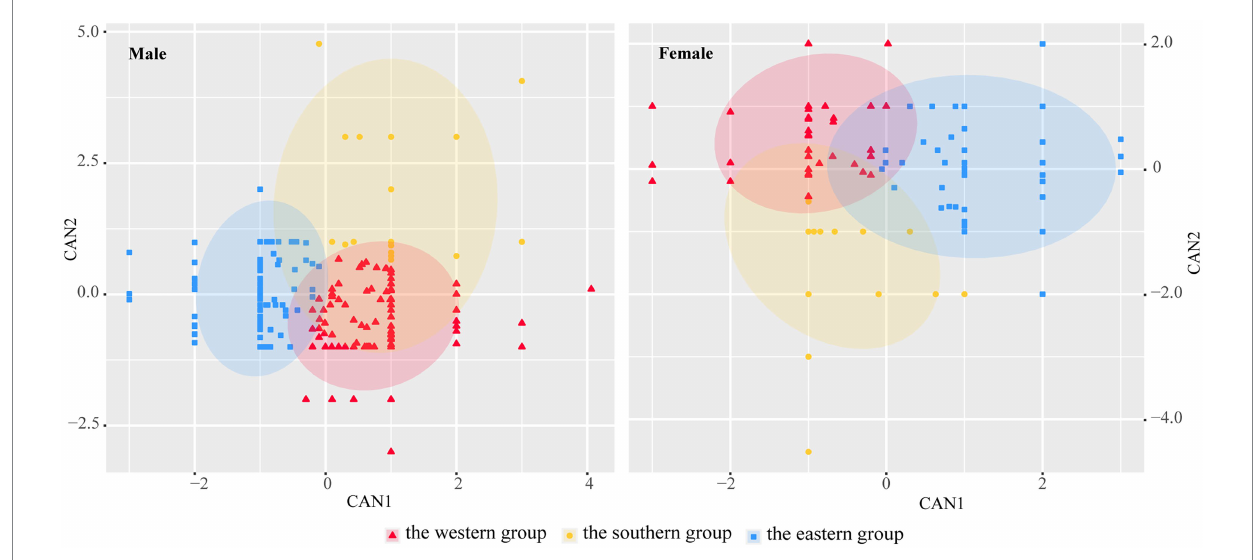
FIGURE 2 Stepwise canonical discriminant analysis based on 20 morphometric traits of Odorrana graminea sensu stricto (Red circle: the western group; Yellow circle: the southern group; and Blue circle: the eastern group).